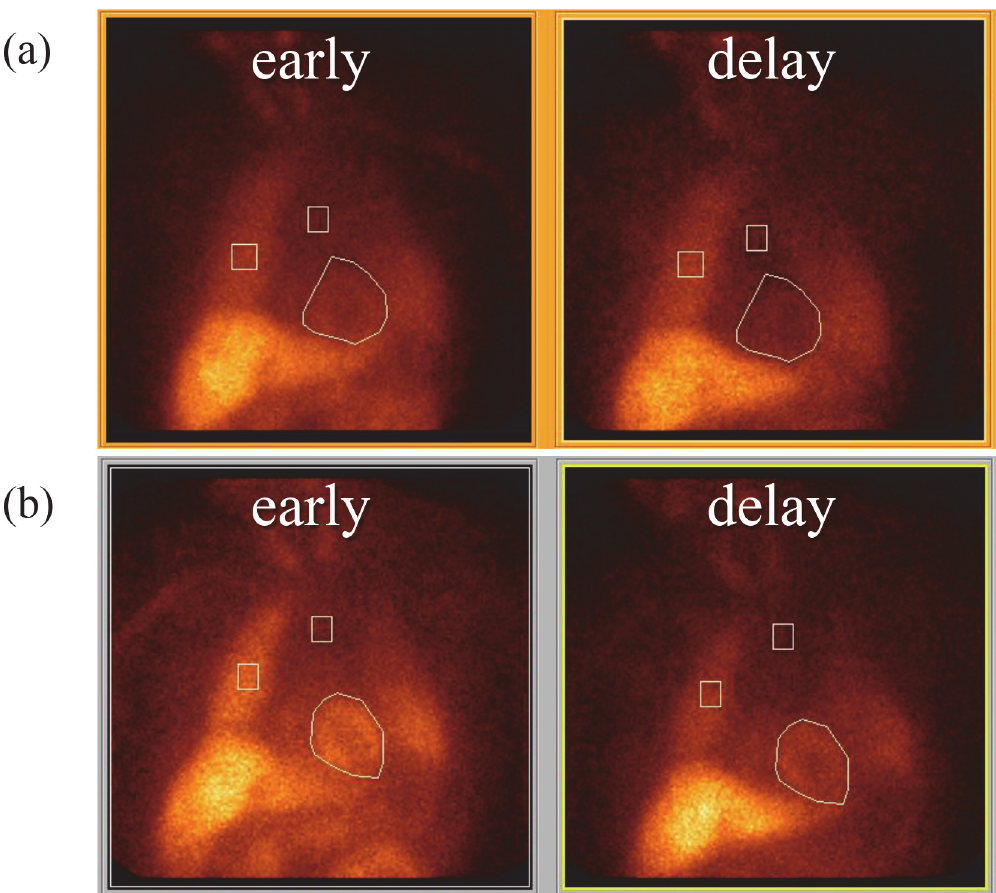
Fig 5. [ 123 I] meta-iodobenzylguanidine (MIBG) cardiac imaging. Early and Delayed. a) 123 I-MIBG myocardial scintigraphy revealed that the heart/mediastinum (H/M) ratio was decreased at the baseline (early, 1.55; delay, 1.32). A reduced HM ratio indicates peripheral noradrenergic depletion. b) Combined immunomodulatory therapies resulted in a remarkable improvement in the H/M ratio (early, 2.38; delay,